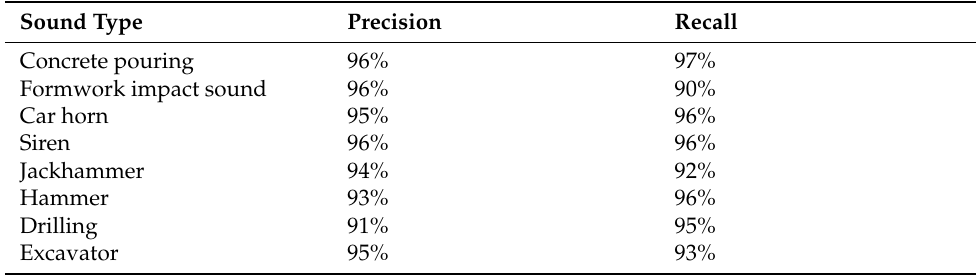
Figure 12. Data ratio by class. Table 1. Data ratio by class.